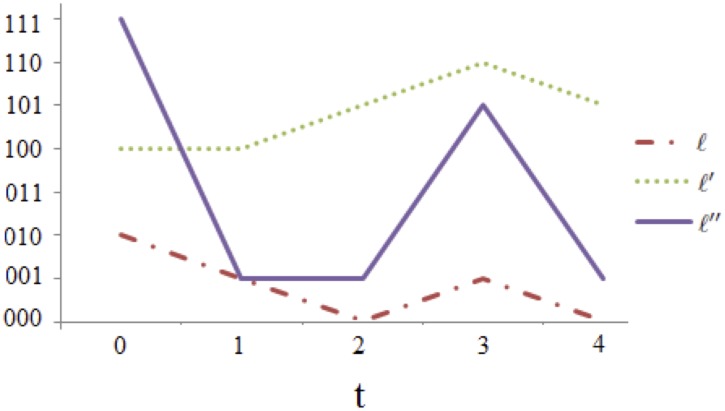
Time series of the three subjects in Table 3.